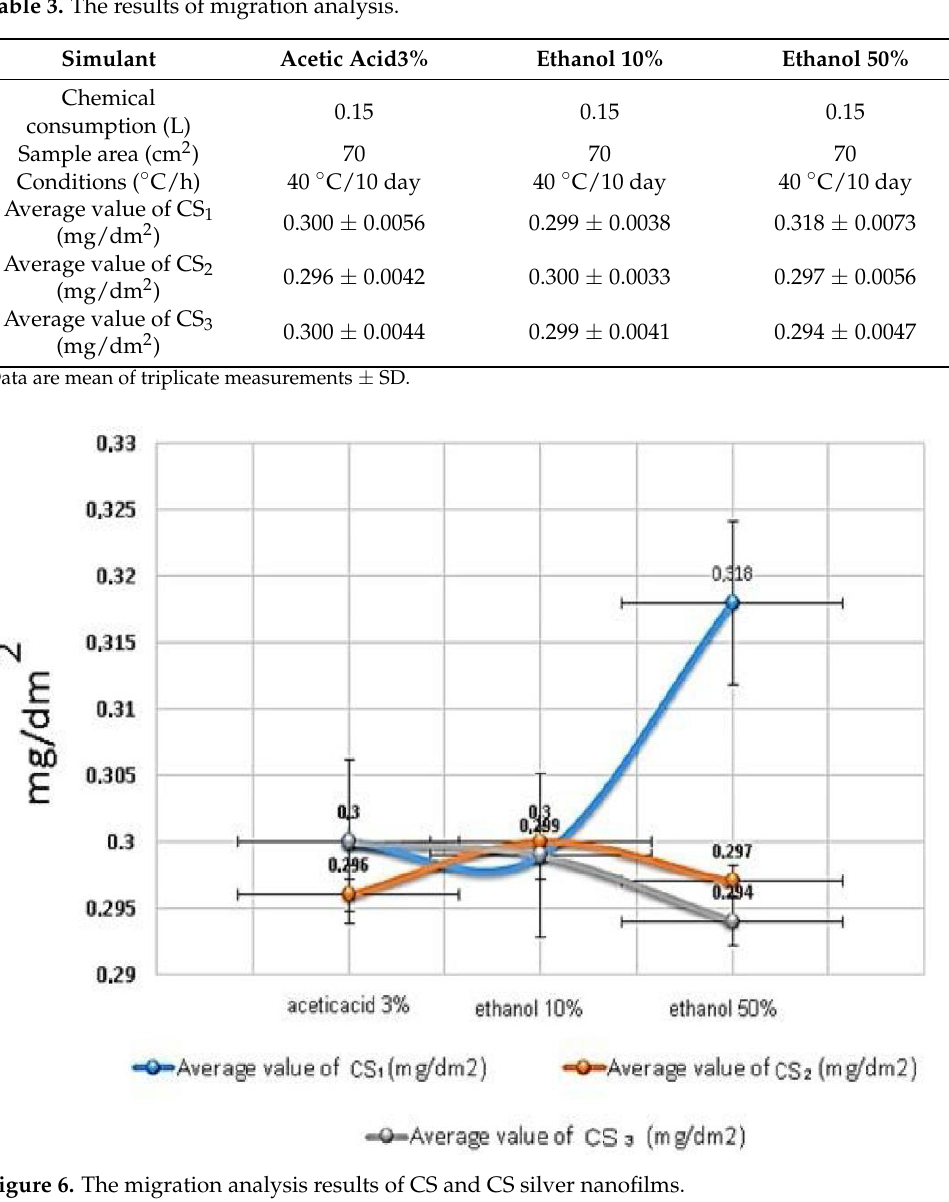
Table 3. The results of migration analysis.